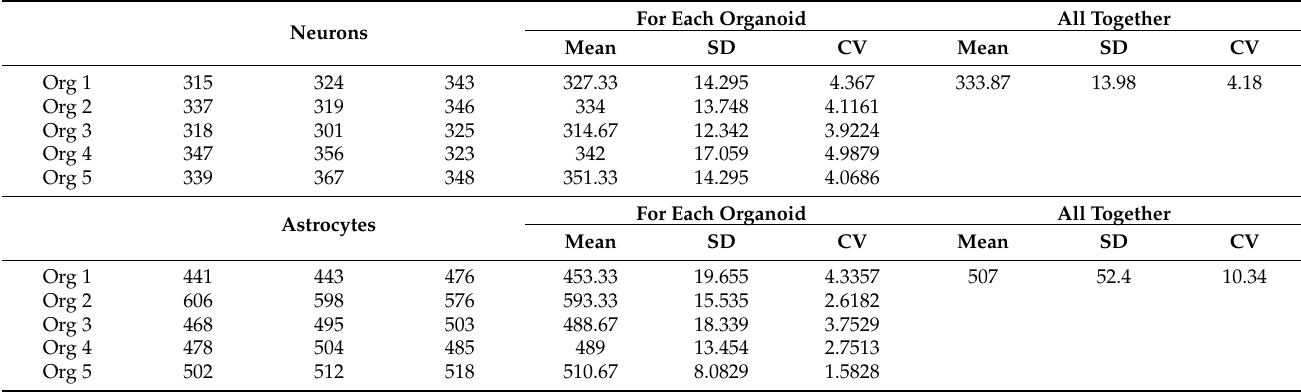
Table 2. Calculations of coefficient of variation for the population of neurons and astrocytes in COs, as measured by MAP2 and GFAP staining. Data are shown as radial coverage ( µ m) in COs. For Each Organoid All Neurons